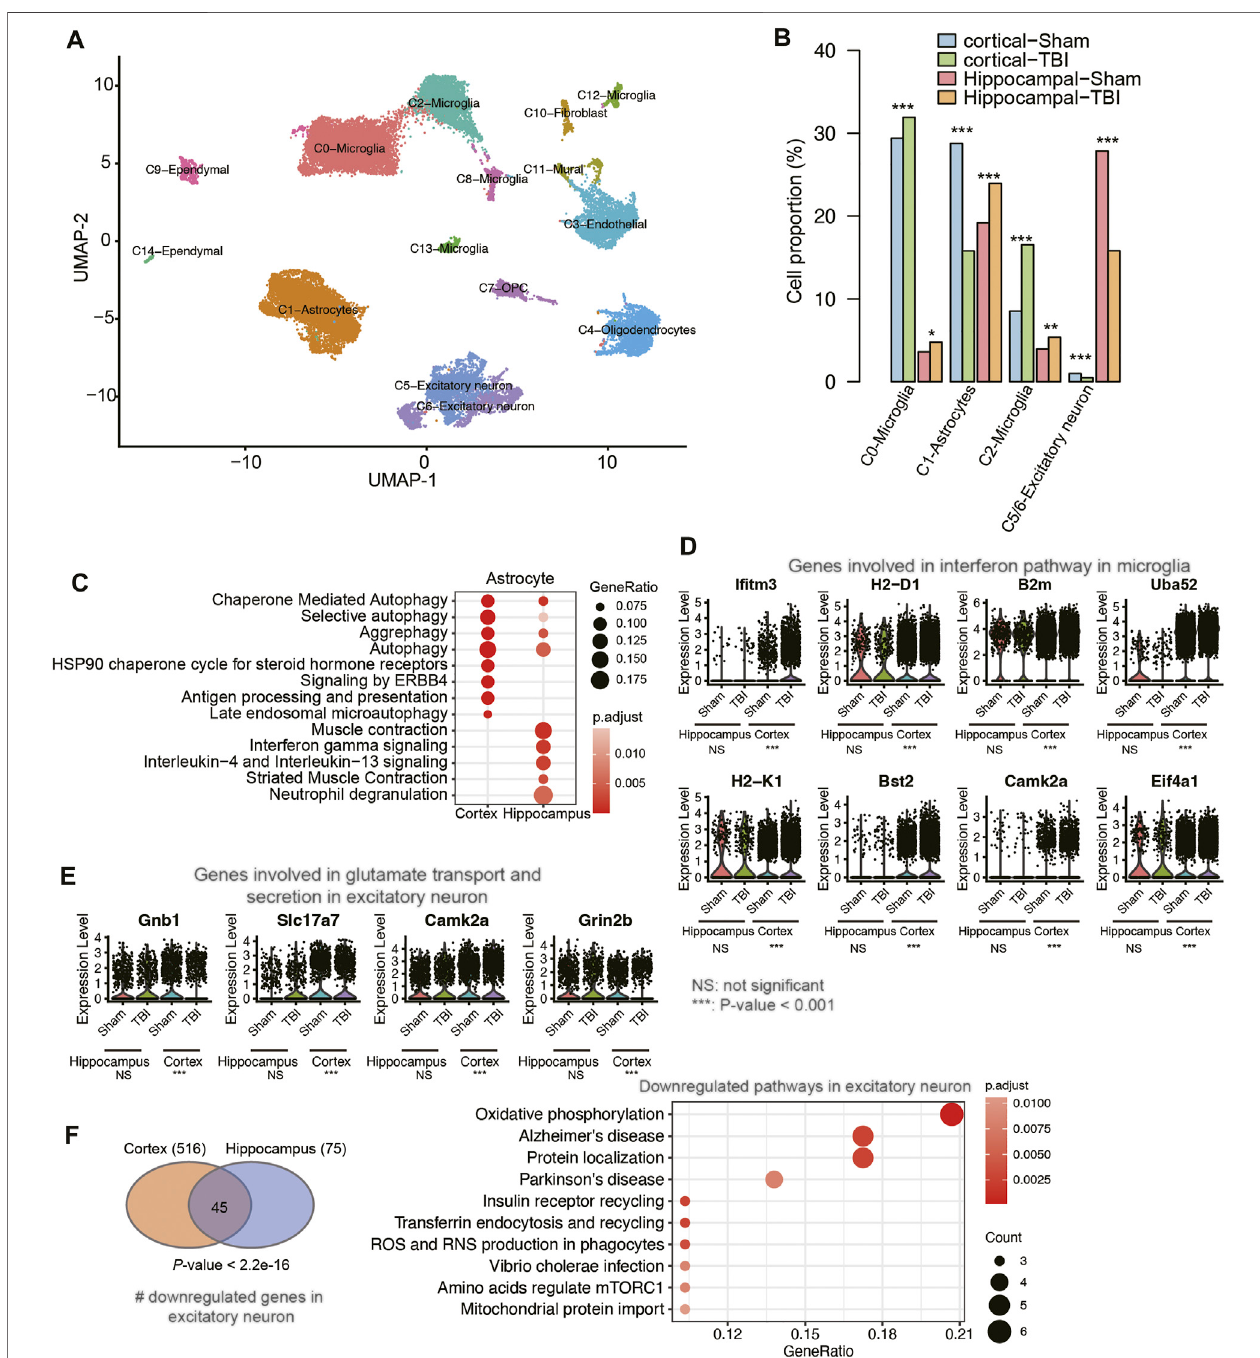
FIGURE 6 | The differences of transcriptional changes between cortical and hippocampal TBI samples. (A) The UMAP analysis for the mouse cortical and hippocampal samples. Each point represents one cell, and the point colors represent the cell clusters. (B) The differential cell proportions between TBI and sham samples from cortex or hippocampus tissues. (C) The pathways enriched by the upregulated genes in the astrocyte of cortical and hippocampal TBI samples. (D) The expression of genes involved in interferon pathway in microglia. (E) The expression of genes involved in glutamate transport and secretion in excitatory neuron. (F) The pathways enriched by the downregulated genes in the excitatory neuron of both cortical and hippocampal TBI samples.